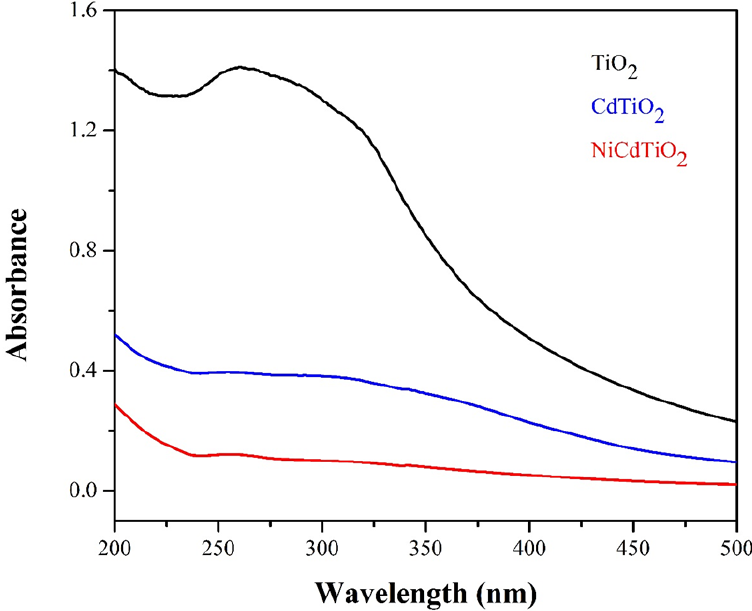
Figure 8. UV – VIS absorption spectra of TiO 2 , CdTiO 2 and NiCdTiO 2. Figure 8. UV–VIS absorption spectra of TiO